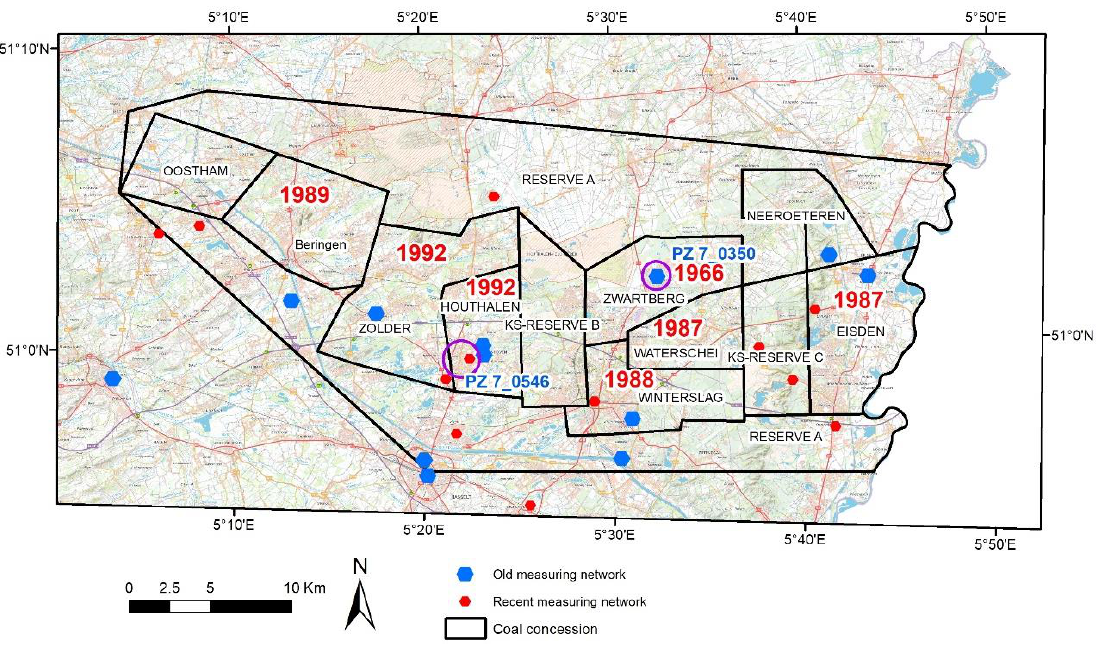
Figure 10. Relevant piezometers available in the study area and the extension of coal concessions with the year of mine closure (in red).